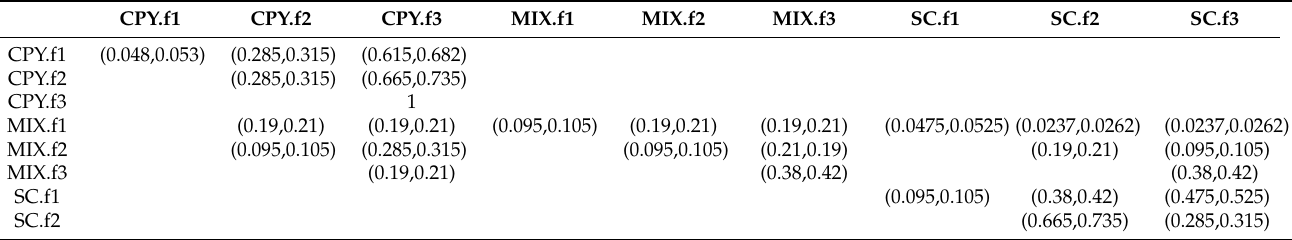
Table 5. Conversion in grinding 2, range of uncertainty